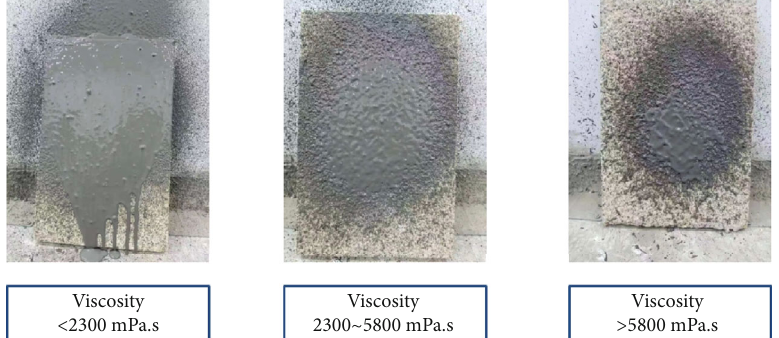
Figure 6: Adhesion of TSL material to the